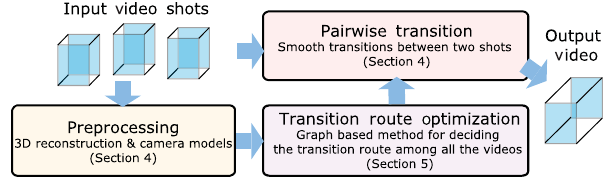
Our system has three stages. The input videos are preprocessed and then fed to the graph based transition route optimization. On the optimal graph route, a smooth transition is computed on each edge between two video shots. Finally a coherent video of the foreground object is generated with seamless transitions between videos from different hand-held